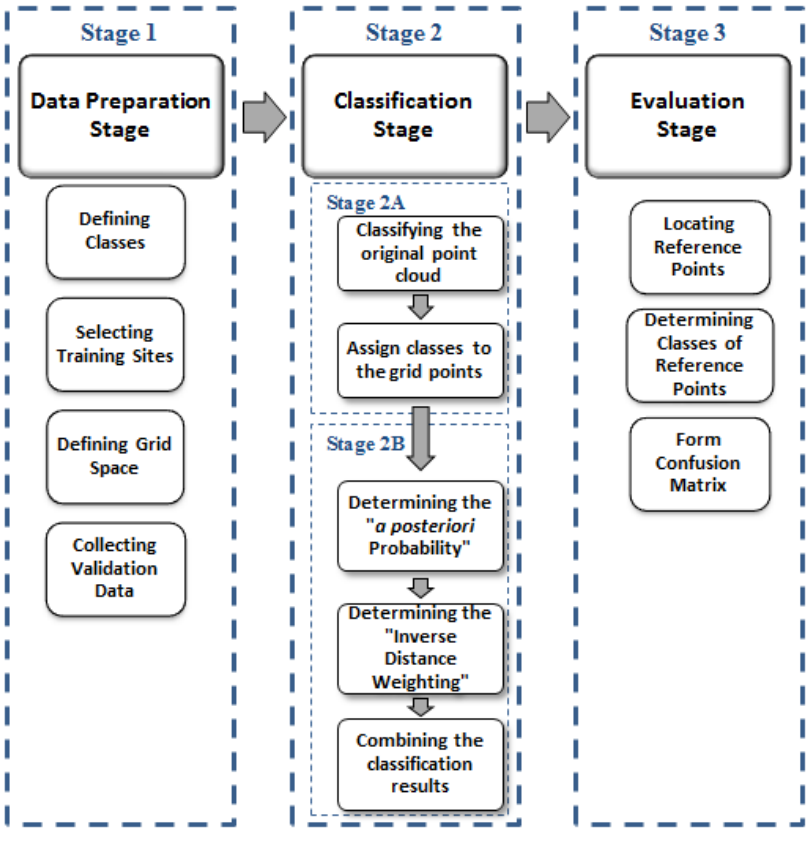
Figure 1: Workflow of the introduced approach for